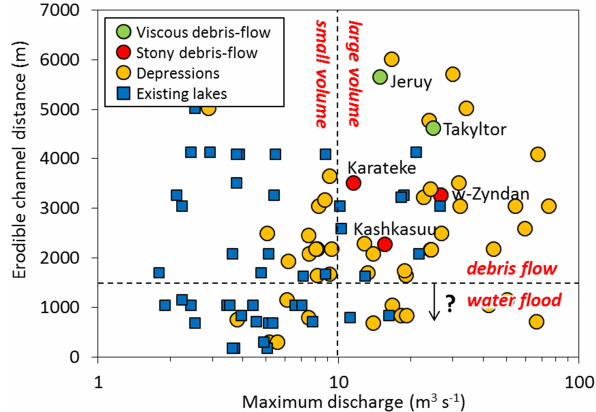
Figure 10. Drainage classification for the study area. The horizontal dashed line separates debris flows from water floods (which have little debris). The vertical dashed line separates high-volume from low-volume